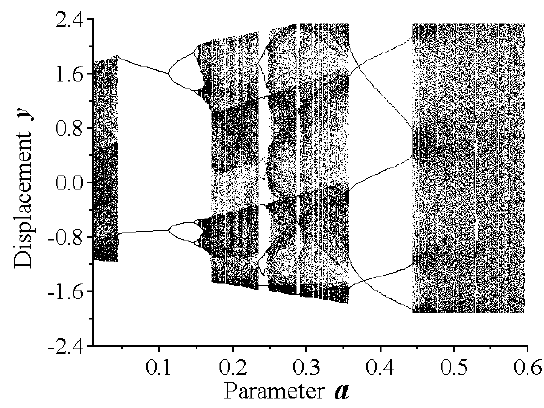
Fig. 7. The largest Lyapunov exponents for b = 0 . 3 , (cid:4) = 1 . 1 and γ = 0 . 5